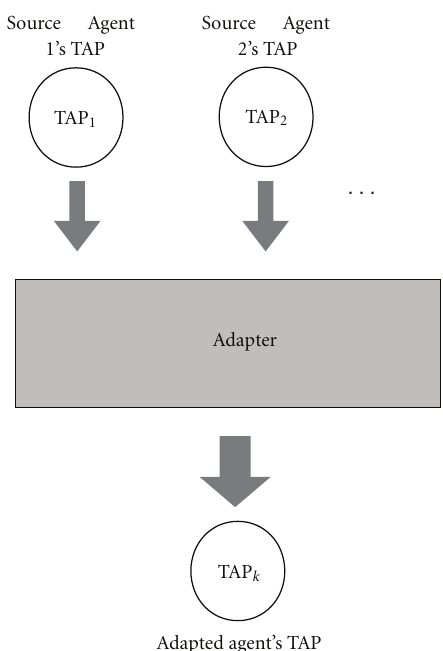
Figure 3: The TAP adaptation process. For each agent, its adapter takes in either one or more TAPs from other agents to generate its own